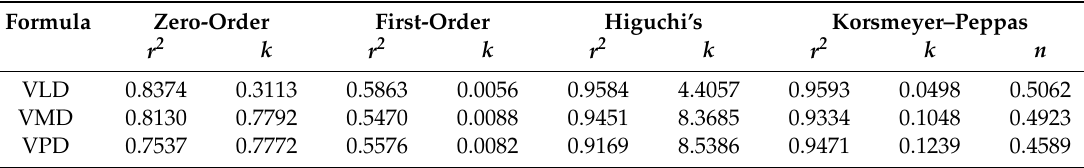
Figure 6. VCM release from in situ forming matrix at the initial experimental period ( A ) and over 7 days ( B ) in PB at pH 7.4 using dialysis tube method. Table 3. Degrees of goodness-of-fit and estimated parameters from curve fittings of the release profiles of vancomycin HCl (VCM)-loaded in situ forming systems in phosphate bu ff er at pH 7.4 using the membrane-less